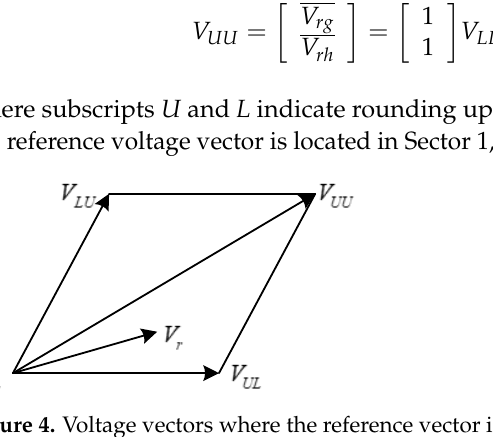
Figure 4. Voltage vectors where the reference vector is rounded up and down.